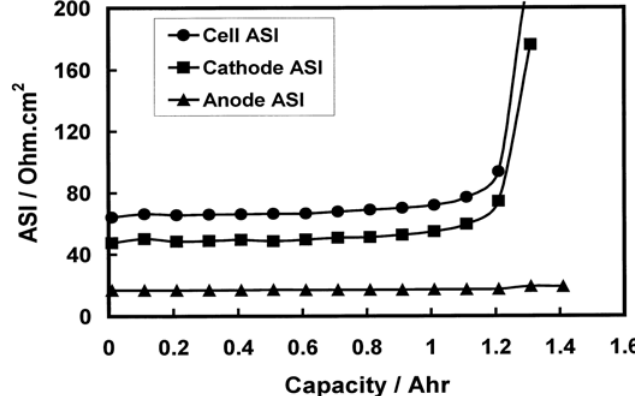
Figure 5. Effect of area specific impedance (ASI) on charge capacity [76].